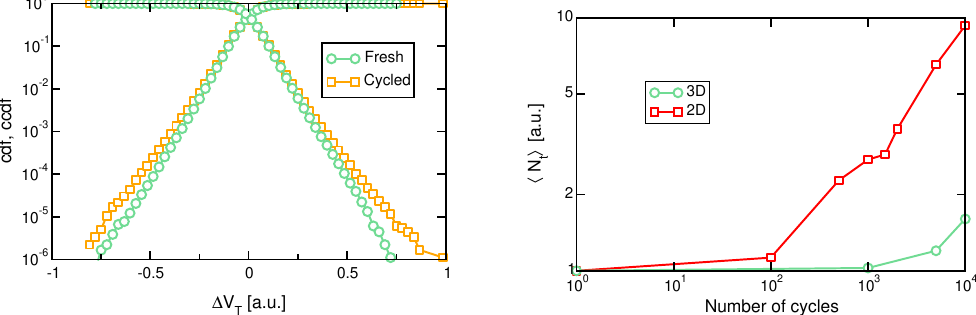
Figure 7. ( Left ) RTN cdf for a 3D NAND before and after cycling to 10k cycles [126], © 2018, IEEE. ( Right ) Average number of RTN traps as a function of cycling [126], © 2018, IEEE.